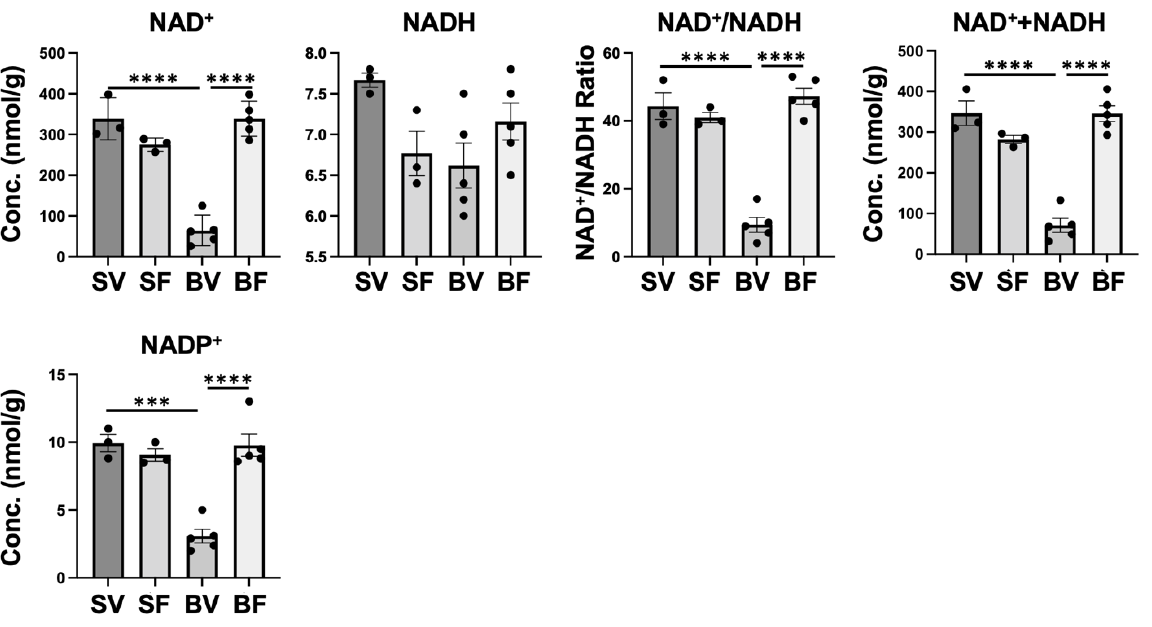
Figure 7. Effects of burn injury and FTI-277 on redox-related metabolites. SV: Sham-Vehicle; SF: Sham-FTI; BV: Burn-Vehicle; BF: Burn-FTI, *** p < 0.001, **** p < 0.0001. Sham-FTI; BV: Burn-Vehicle; BF: Burn-FTI, *** p < 0.001, **** p <